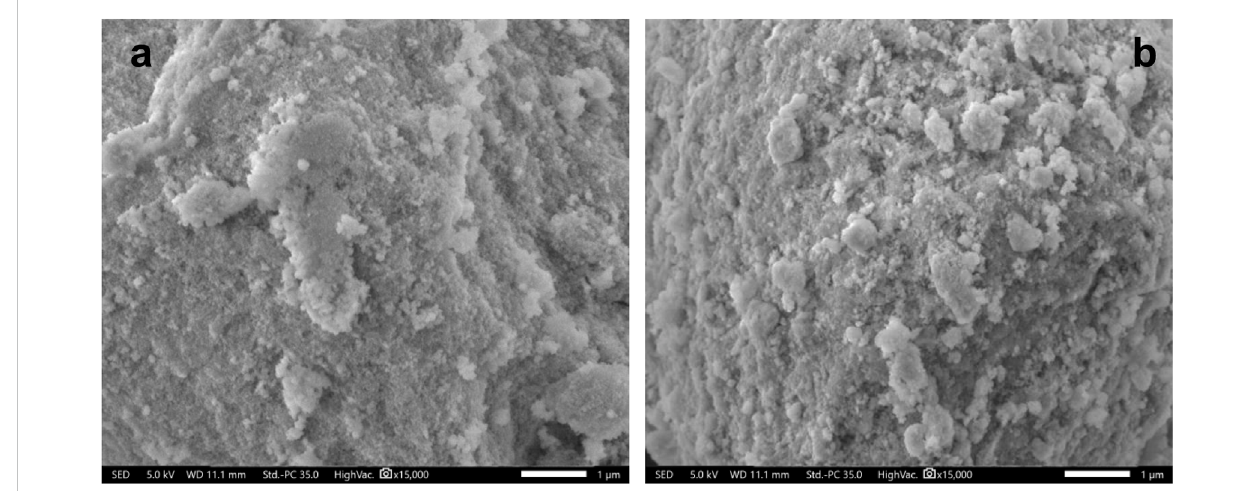
FIGURE 5 The comparison of scanning electron micrographs of (A) pristine CeO 2 and (B) Fe doped CeO 2 .